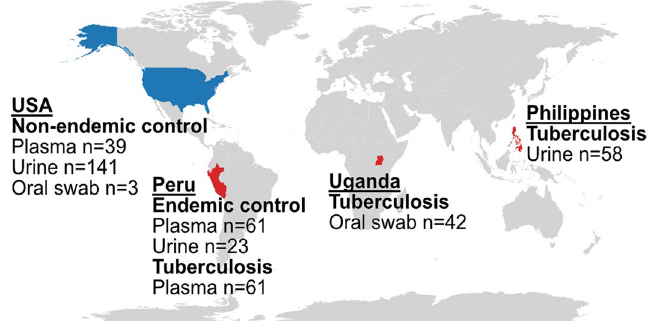
Figure 1. Geographic distribution of samples included in this study. High tuberculosis burden countries are shaded in red.